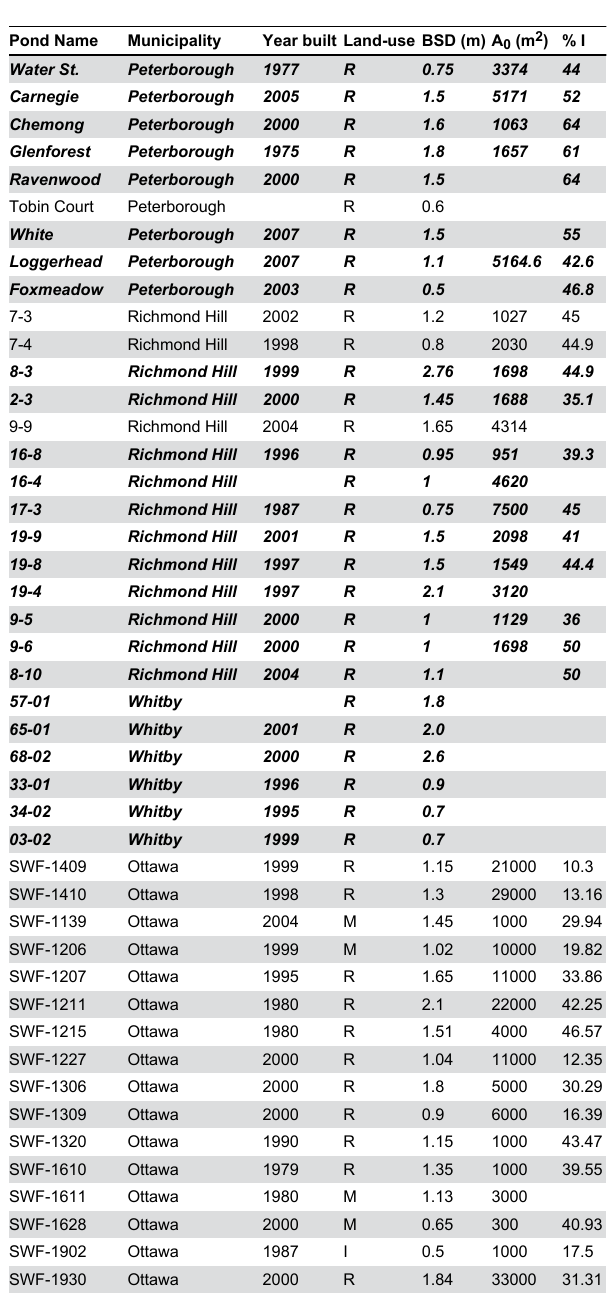
Table 1. Selected characteristics of urban ponds in this